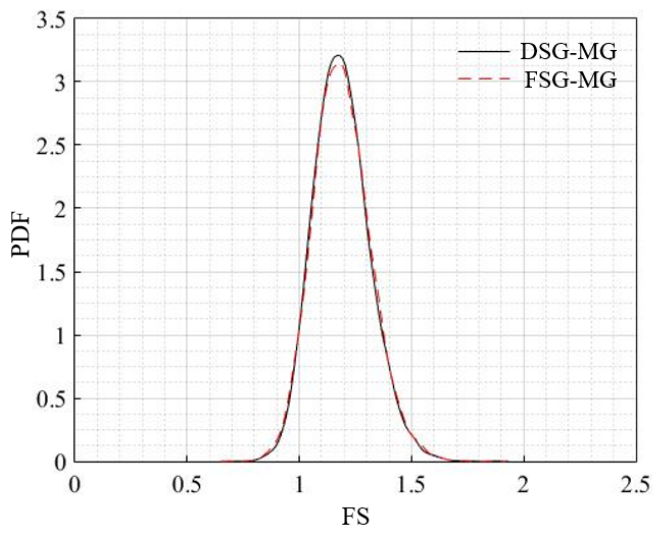
Figure 7. PDFs of the obtained safety factor based on two methods.